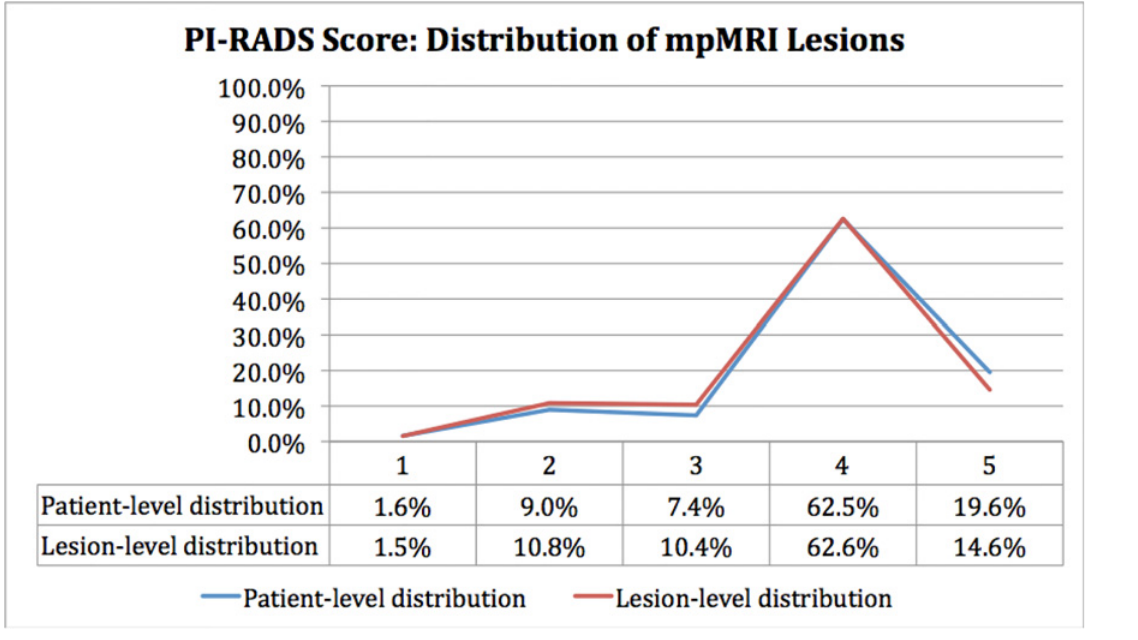
Fig 9. Distribution of lesions on mpMRI stratified by PI-RADS